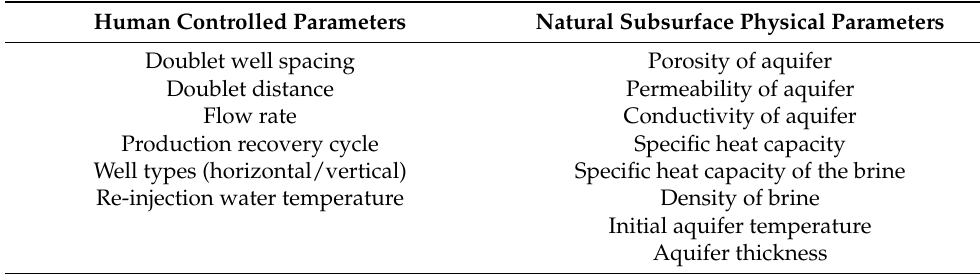
Table 1. Effective parameters for heat production from a doublet geothermal